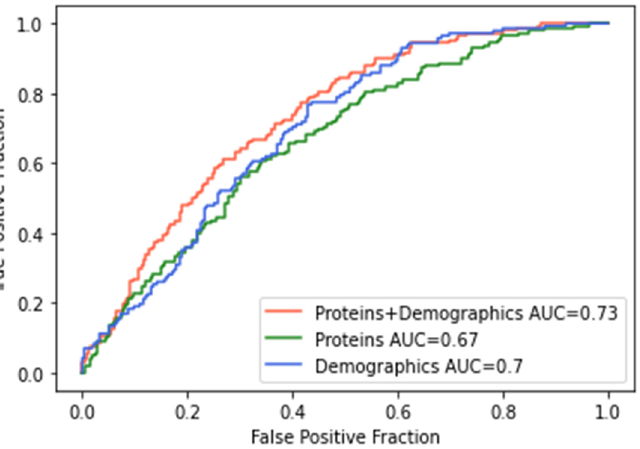
Figure 2. Receiver operating characteristics (ROC) curves for machine learning classifier for moderate- to-severe obstructive sleep apnea in replicated and CPAP proteins. Model 1 (red line) included the five replicated proteins as well as demographic variables (i.e., age, sex, BMI) and achieved the highest accuracy of 66%; Model 2 (green line) included only the five proteins, and Model 3 (blue line) included only demographic variables.